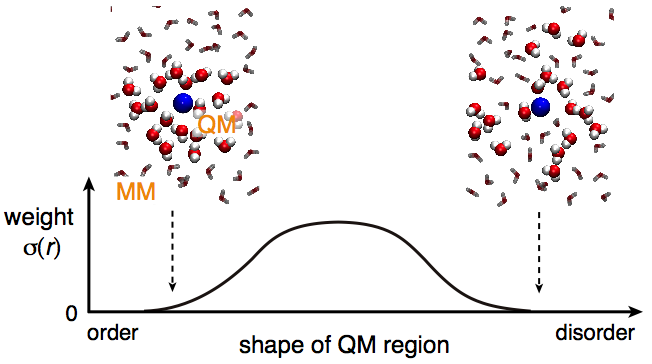
Scheme 1. Concept of weight function. The horizontal axis represents a conceptual index related to the degree of disorder of the QM region.